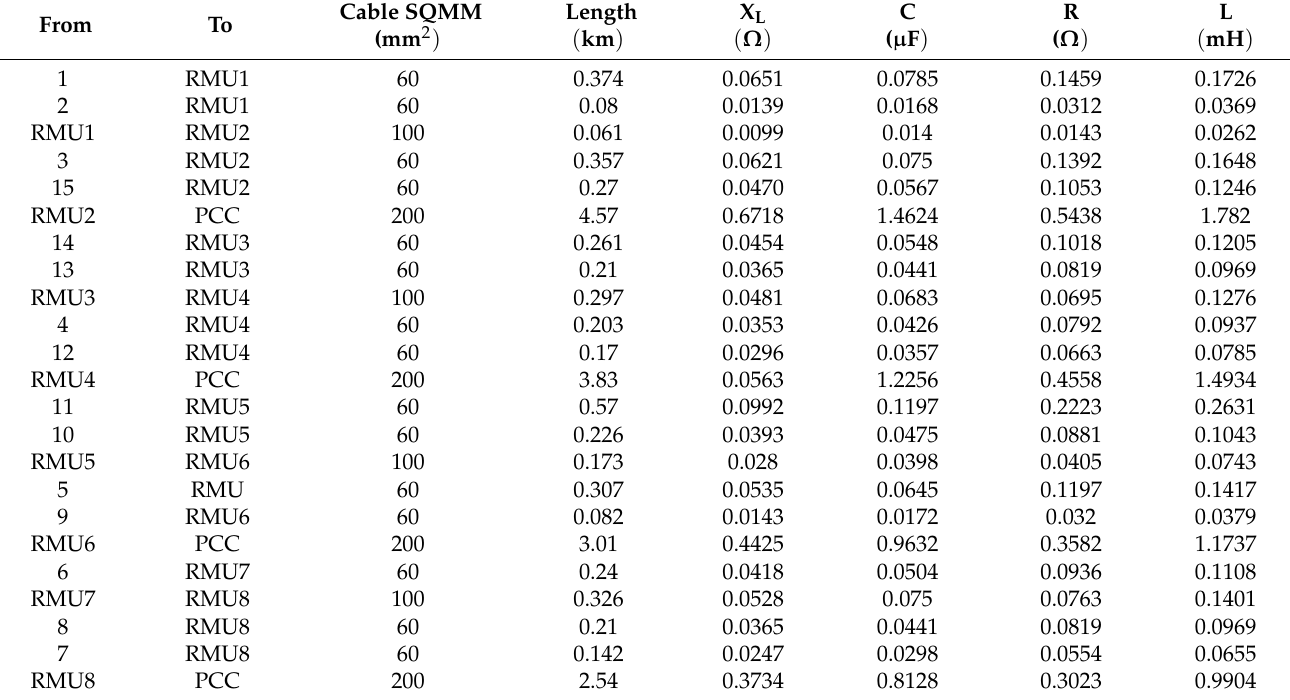
Table 1. Inner cable parameters of Dongbok wind farm.